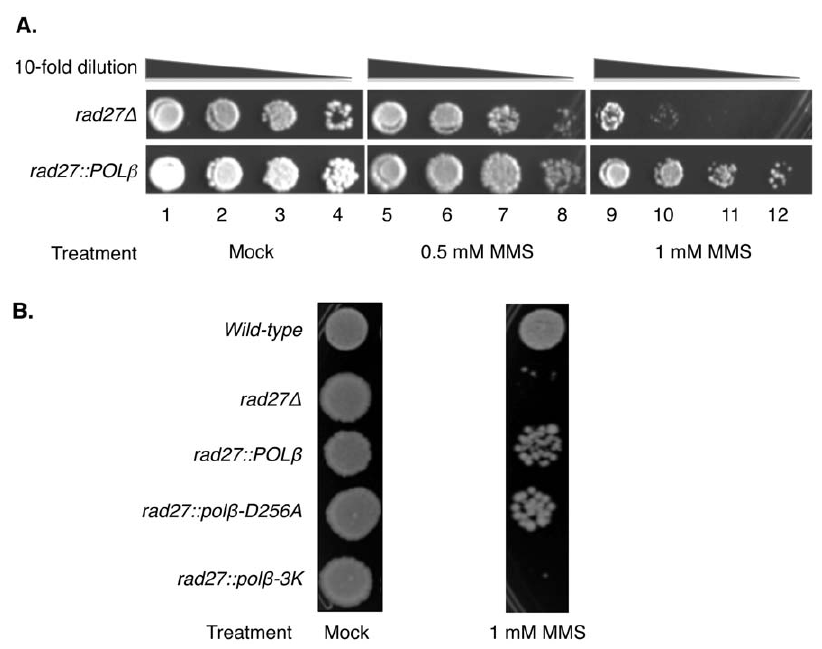
Figure 6. Human POL b rescues MMS sensitivity in S.cerevisiae , null for rad27 . Experiments were conducted as described in Materials and Methods. Briefly, ten-fold dilutions (as shown) were set-up for each strain and culture (5 m l of each dilution) were spotted onto freshly prepared YPDA plates containing the indicated concentration of MMS. Photographs were taken on day 3 or 4 after plating. (A) Mock treatment, lanes 1–4; 0.5 mM MMS treatment, lanes 5–8; 1 mM MMS treatment, lanes 9–12. (B) Rescue of MMS sensitivity by human Pol b dRP lyase. Sensitivity to MMS was scored by spotting cultures of various strains on plates either without (mock) or with 1 mM of MMS. Resistance to MMS was observed in rad27 null strains that contain POL b or pol b -D256A . Lack of cell growth was observed only in the rad27 null strains ( rad27 D ) or the strain containing mutations in the dRP lyase domain ( rad27 :: pol b -3K ). Strains are indicated on the left.